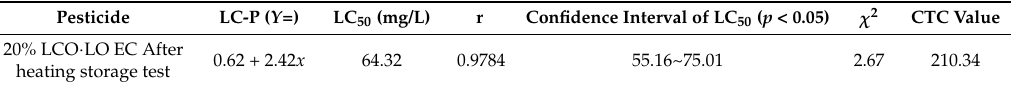
Table 6. Toxicity of 20% LCO · LO EC before and after hot storage to Aphis citricola van der Goot (24 h). Pesticide LC-P ( Y =) LC 50 (mg/L) r Confidence Interval of LC 50 ( p < 0.05) χ 2 CTC Value 20% LCO · LO EC After heating storage test